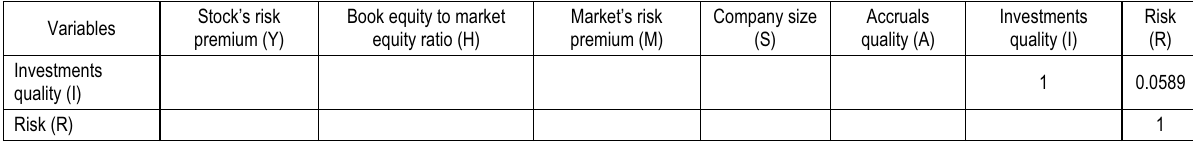
Table 5 (cont.). Alignment between variables